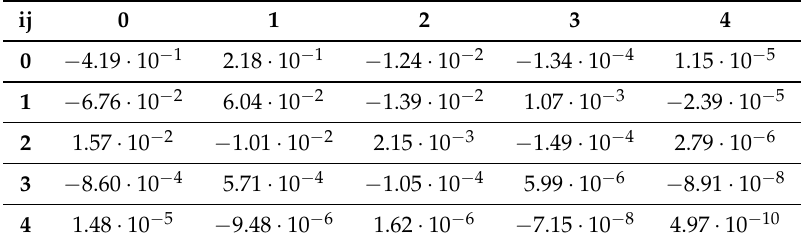
Table A3. Coefficients α i , j to calculate C P ( λ , β